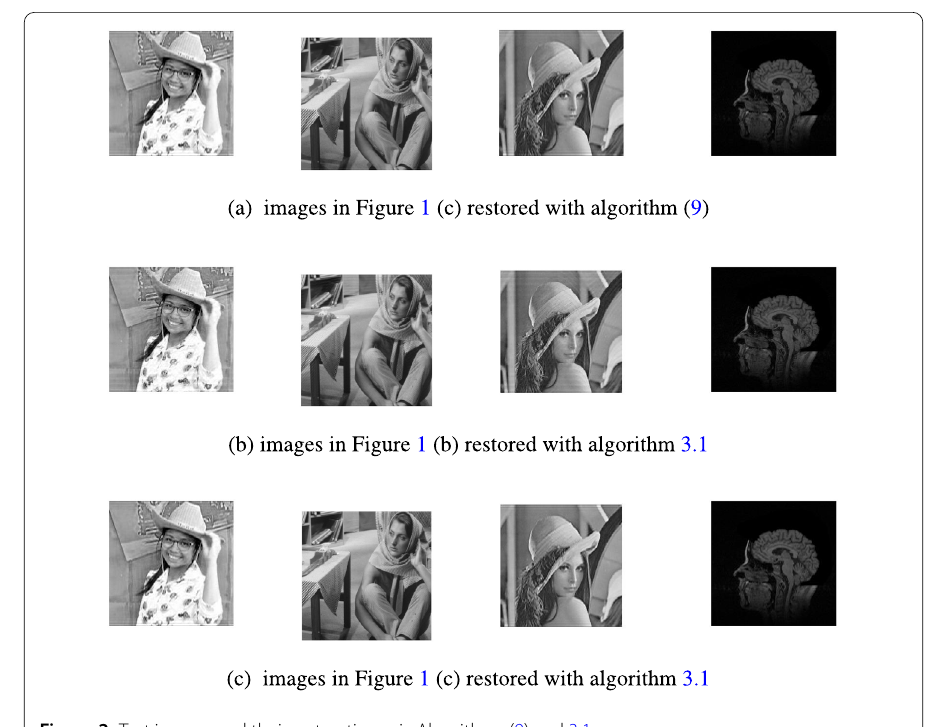
Figure 2 Test images and their restorations via Algorithms (9) and 3.1